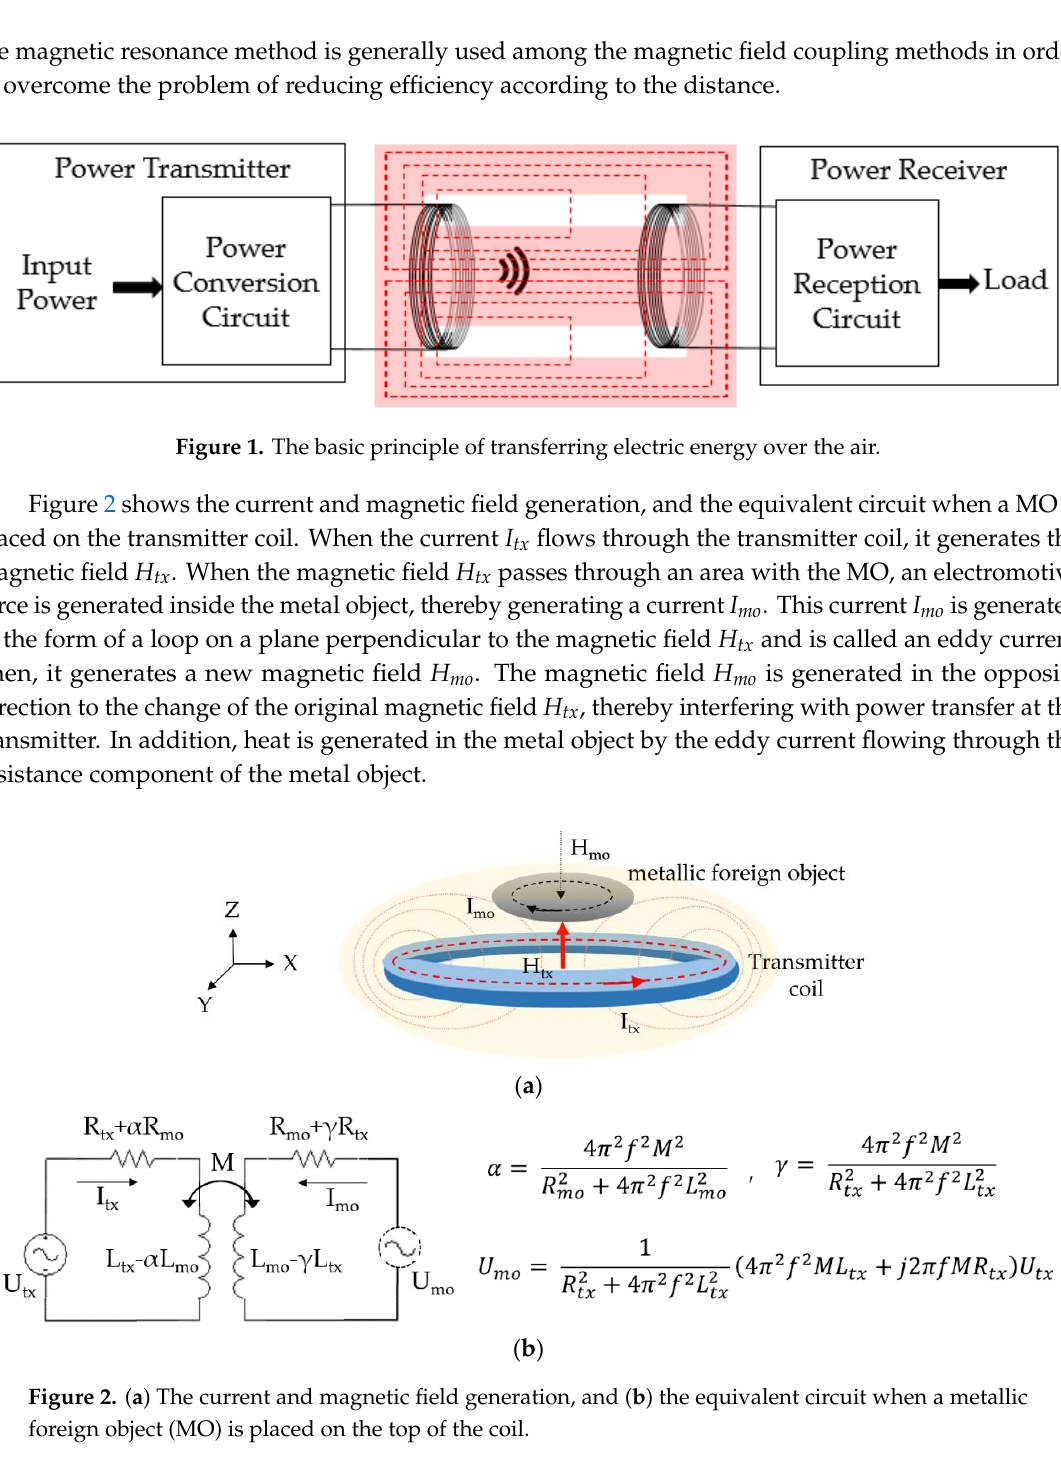
Figure 2. ( a ) The current and magnetic field generation, and ( b ) the equivalent circuit when a metallic foreign object (MO) is placed on the top of the coil.